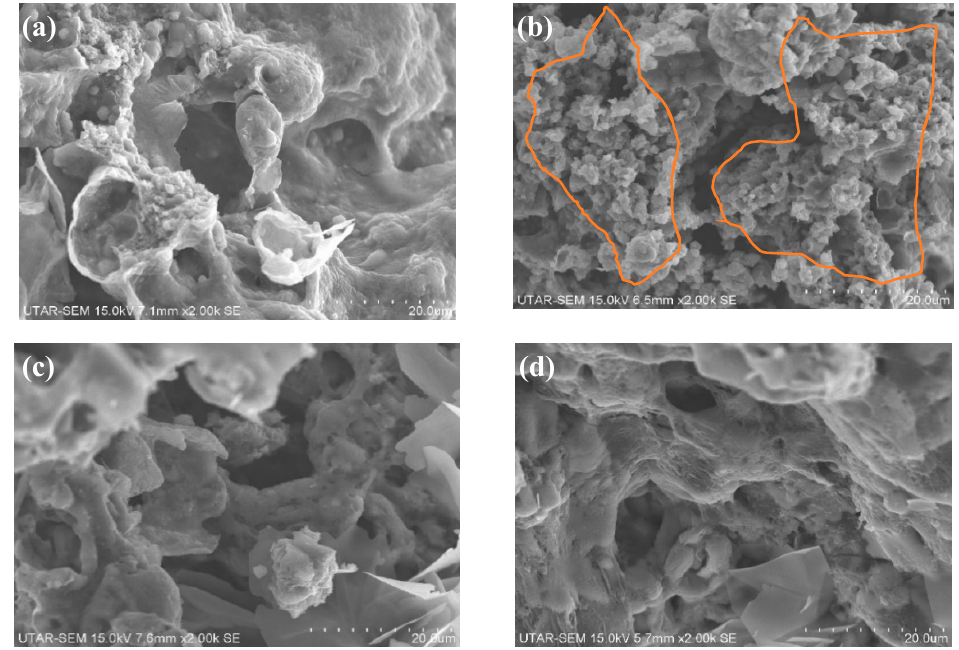
Figure 7. Char morphology: ( a ) BAIC 1-0, ( b ) BAIC 3-5, ( c ) BAIC 5-0 and ( d ) BAIC 10-0.